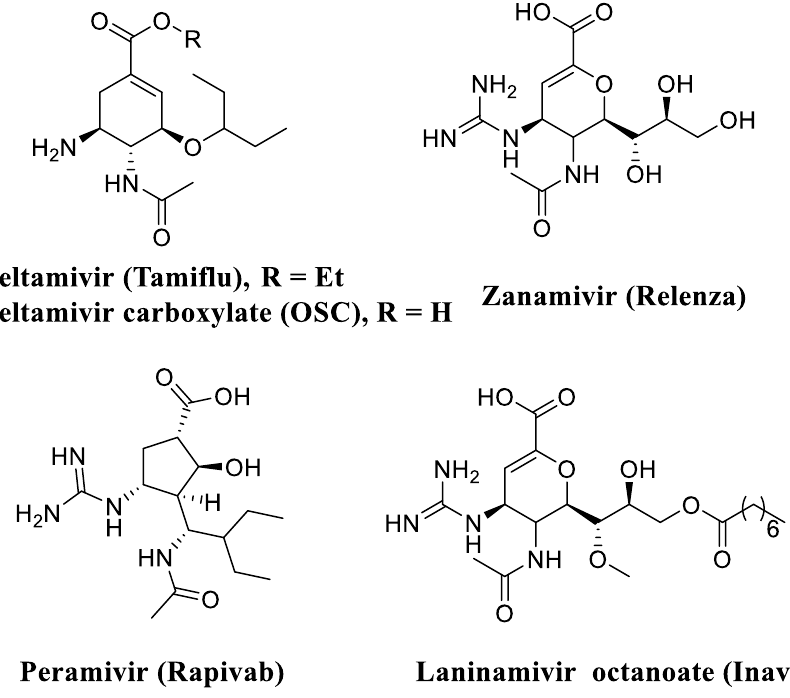
Figure 1. Structures of approved NA inhibitors used in the treatment of influenza virus infection.